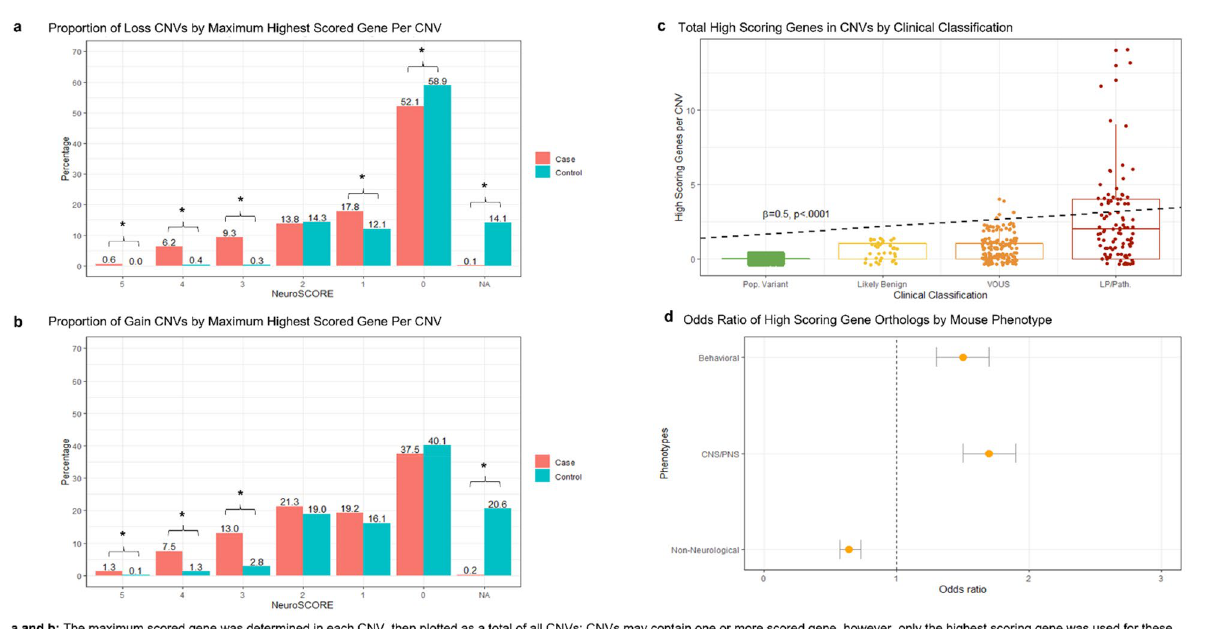
Figure 3. NeuroSCORE applied to human case–control cohorts and mouse phenotype